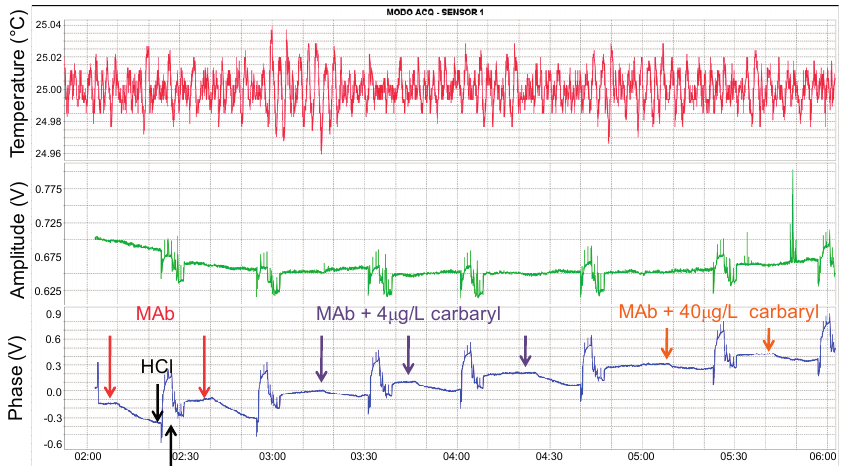
Figure 10. Real-time LW immunosensor response to analyte concentrations obtained with the AW-BIO v1.8 Software (AWSensors). Lower record: real-time phase voltage monitoring of consecutive carbaryl immunoassays. Increasing carbaryl concentrations were assayed with a constant LIB-CNH45 concentration of 2 μ g/mL and a BSA-CNH concentration of 10 μ g/mL. The regeneration (0.1 M HCl + PBST) is indicated whit a black arrow only for the first assay. Middle record: real-time monitoring of amplitude voltage in the same experiment. Upper record: real-time monitoring of the temperature during the